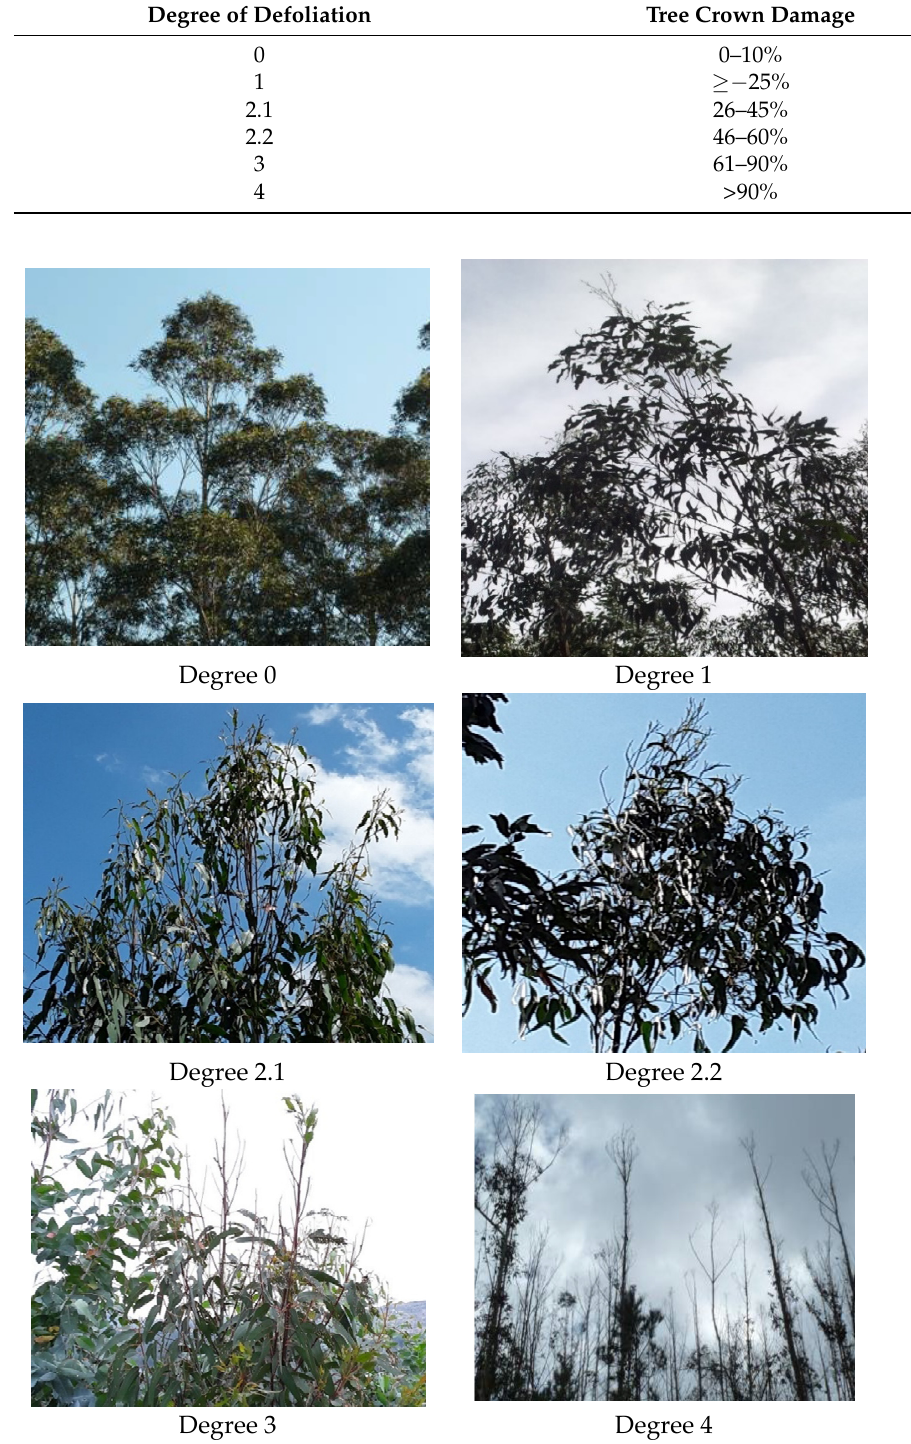
Figure 4. Photographic record of the defoliation degrees according to the GOSSGE protocol.